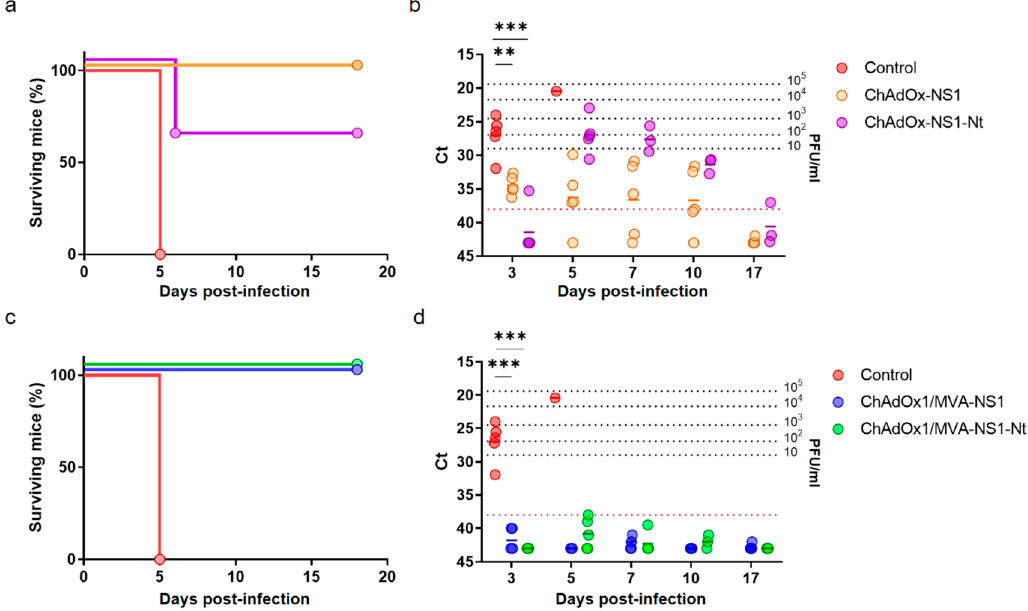
Figure 7. Long-lasting protection of immunized IFNAR(- / -) mice against a lethal challenge with BTV-4M. Groups of IFNAR(- / -) mice ( n = 5) were immunized with ( a , b ) a single dose of 10 8 IU per mouse of ChAdOx1-NS1 or ChAdOx1-NS1-Nt or ( c , d ) following a heterologous prime-boost regimen consisting of an initial dose of 10 8 IU per mouse of ChAdOx1-NS1 or ChAdOx1-NS1-Nt (prime) followed by a second dose of 10 7 PFU per mouse of MVA-NS1 or MVA-NS1-Nt (boost), respectively, administered 28 days apart. Immunized and non-immunized mice were challenged with a lethal dose (10 PFU) of BTV-4M at day 160 post-immunization. ( a , c ) Survival rates after infection. Statistical di ff erences between the curves were calculated using Log-rank test. ( b , d ) Detection of BTV-4M in blood of non-immunized and immunized IFNAR(- / -) mice after challenge by RT-qPCR. Expression of mRNA of segment 5 (encoding NS1 protein) was quantified at 3, 5, 7, 10 and 17 d.p.i. Results are expressed as Ct (left y -axis) and PFU equivalents (right y-axis and dotted horizontal lines). Cut-o ff Ct ≥ 38 (dotted pink line). Di ff erences between groups were calculated by multiple t test analysis using the Sidak–Bonferroni method. ** p -value < 0.02; *** p -value < 0.001.